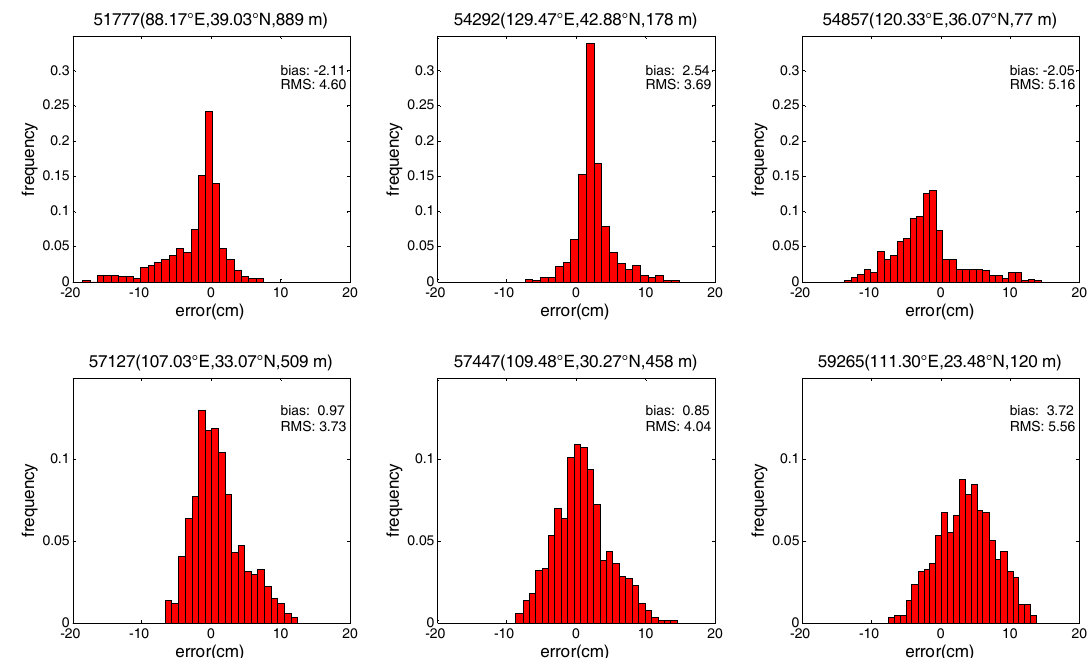
Figure 6. Frequency histograms of error distribution for the SAAS model at six radiosonde stations.